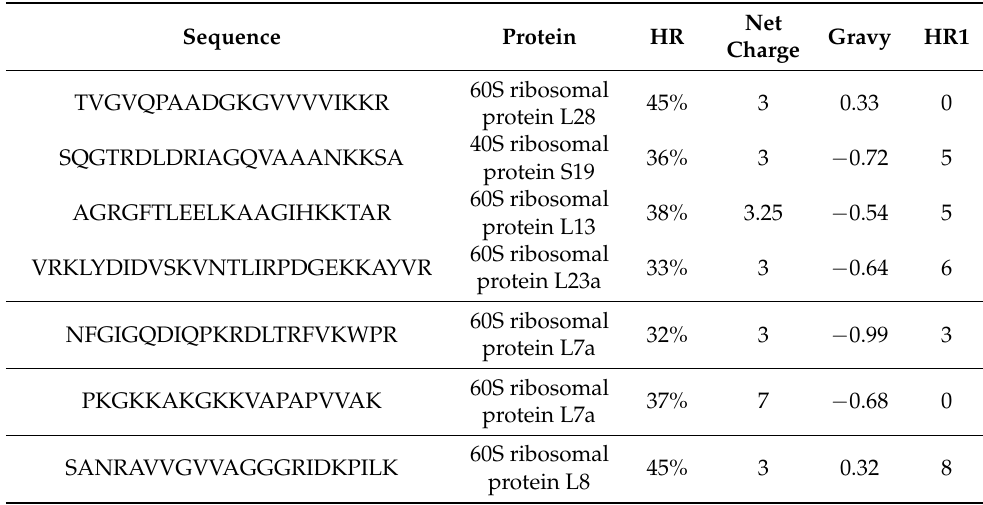
Table 1. Sequences of ribosomal proteins with similar characteristics to AMPs. Hydrophobic residue (HR) on the same